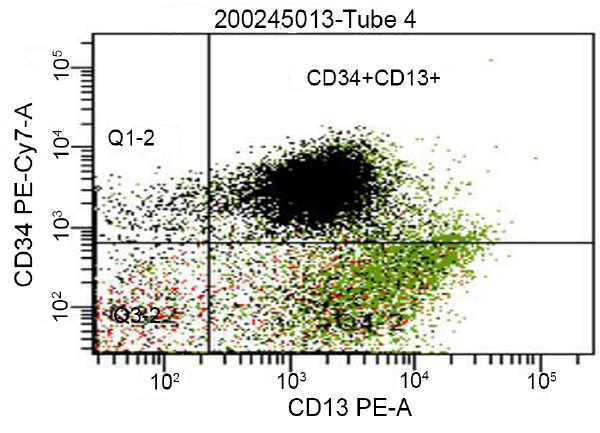
Figure 2. Flow cytometric quantification and immunophenotyping of leukemic stem cells in our patient with acute myeloid leukemia